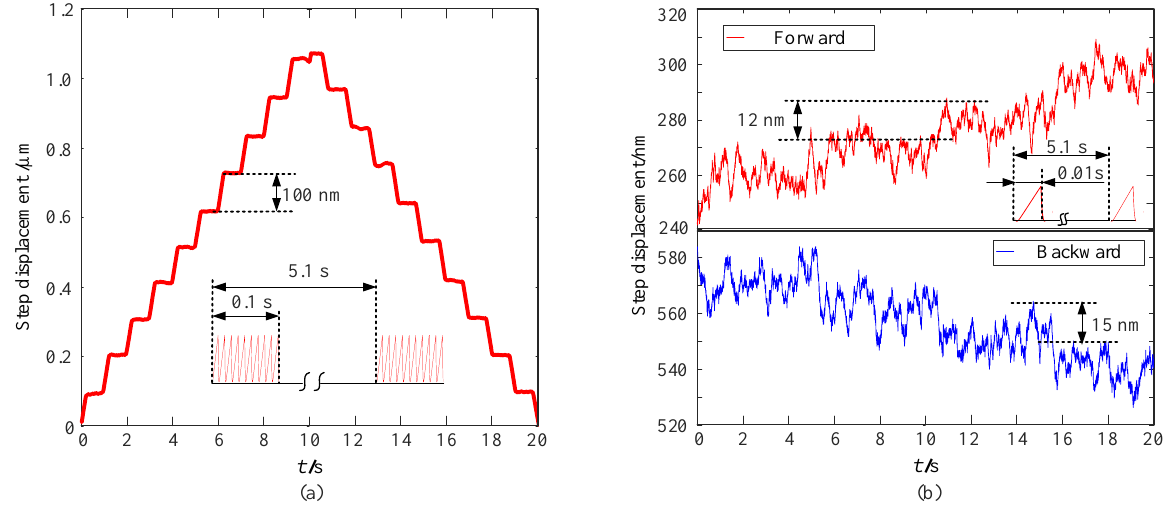
Figure 11. Step characteristics of the stage. ( a ) Driving signal cycle number is 10. ( b ) Driving signal cycle number is 1.